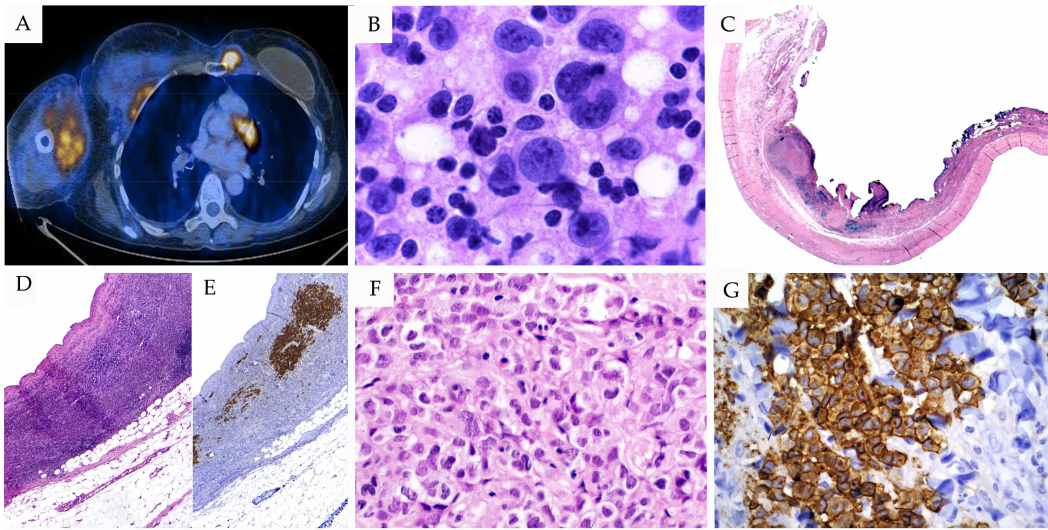
Figure 3. Breast implant-associated ALCL with systemic involvement. ( A ) 18 F-fluorodeoxyglucose- positron emission/computerized tomography (FDG-PET/CT) scan demonstrating hypermetabolic activity in the anterior right thorax and upper arm soft tissues accompanied by muscle and cutaneous involvement, maximum standardized uptake value-6 (SUV max -6). ( B ) Fine needle aspirate showing large neoplastic cells with abundant eosinophilic cytoplasm and eccentric horseshoe-shaped nuclei with multiple nucleoli (H&E stain, 630 × ). ( C ) Low-power view demonstrating capsule engrossment and extensive lymphoma infiltrate (H&E stain 25 × ). ( D , E ) Infiltration of the neoplastic cells to the surrounding soft tissue confirmed by CD30 immunostaining (H&E stain 50 × and CD30 immunostaining 50 × ). ( F ) Sheets of large atypical neoplastic cells, as well as some occasional hallmark cells (H&E stain, 400 × ). ( G ) Neoplastic cells show strong and homogenous staining of CD30 (immunohistochemistry, 400 × ). Abbreviations: H&E: hematoxylin and